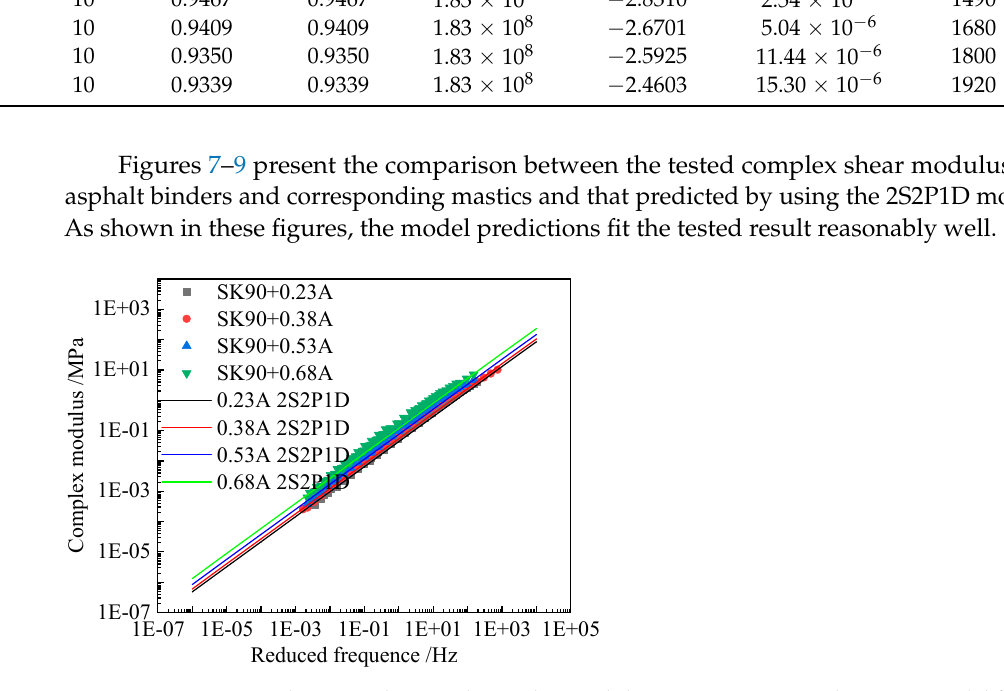
Figure 8. Comparison between the tested complex modulus master curves and 2S2P1D model fitted results of KL70 (A) asphalt mastics.